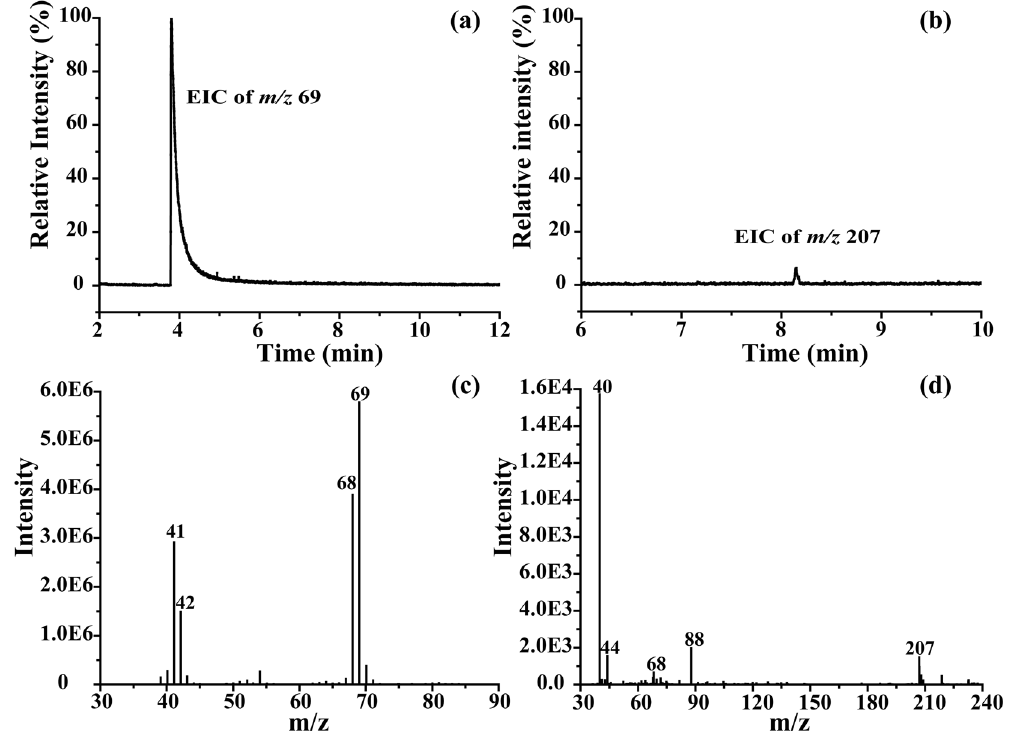
Figure 6. Extracted ion chromatograms of m / z 69 and m / z 207 signals and corresponding mass spectra at 4 min and 8.2 min elution time in GC-MS analysis of 1-pyrroline (100 ppm in CH 2 Cl 2